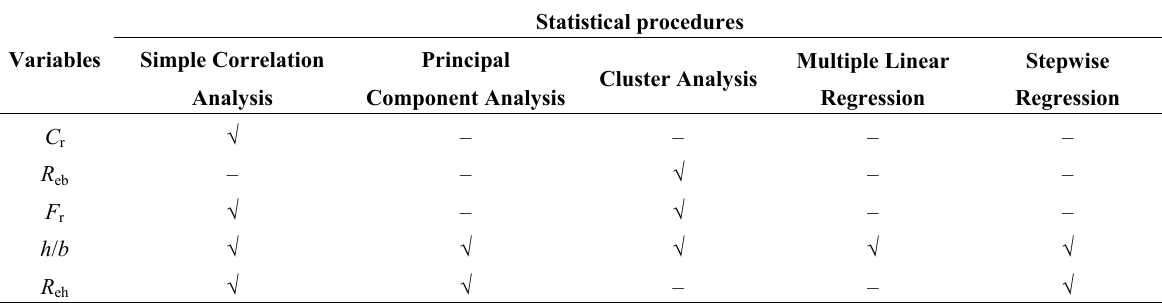
Table 8. Statistical